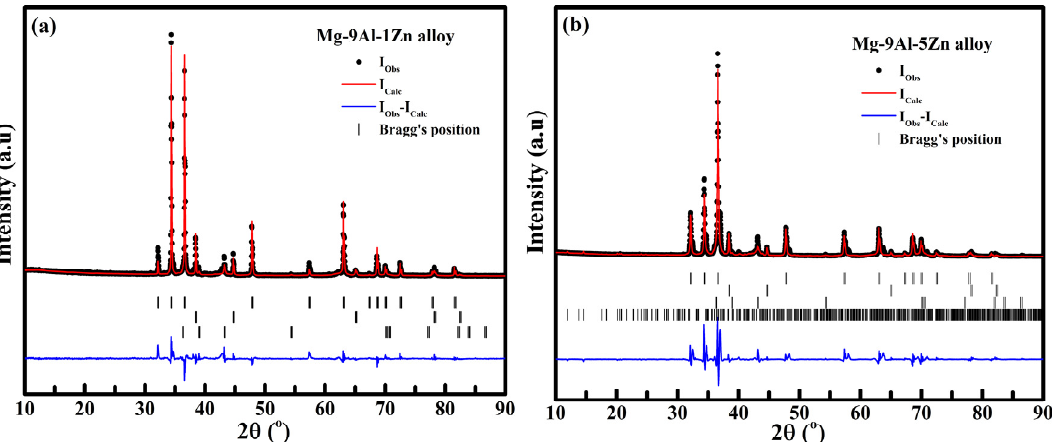
Figure 5. Rietveld refinement results for the Mg-Al-Zn alloy foams: ( a ) porous Mg-9Al-1Zn alloy and ( b ) porous Mg-9Al-5Zn alloy.